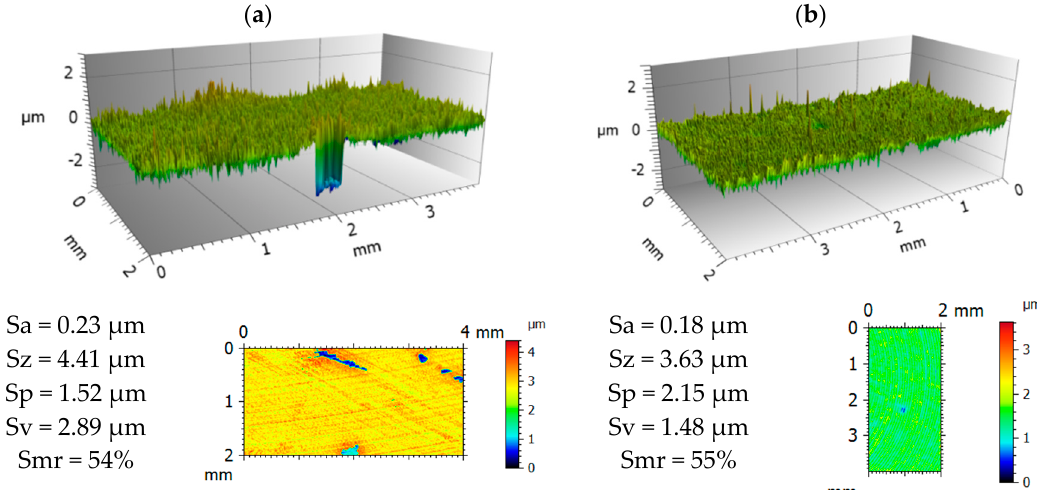
Figure 9. 3D view and statistical characteristics of samples surface of Vancron 40 steel after: ( a ) G-SN and ( b ) T-B130-SN.